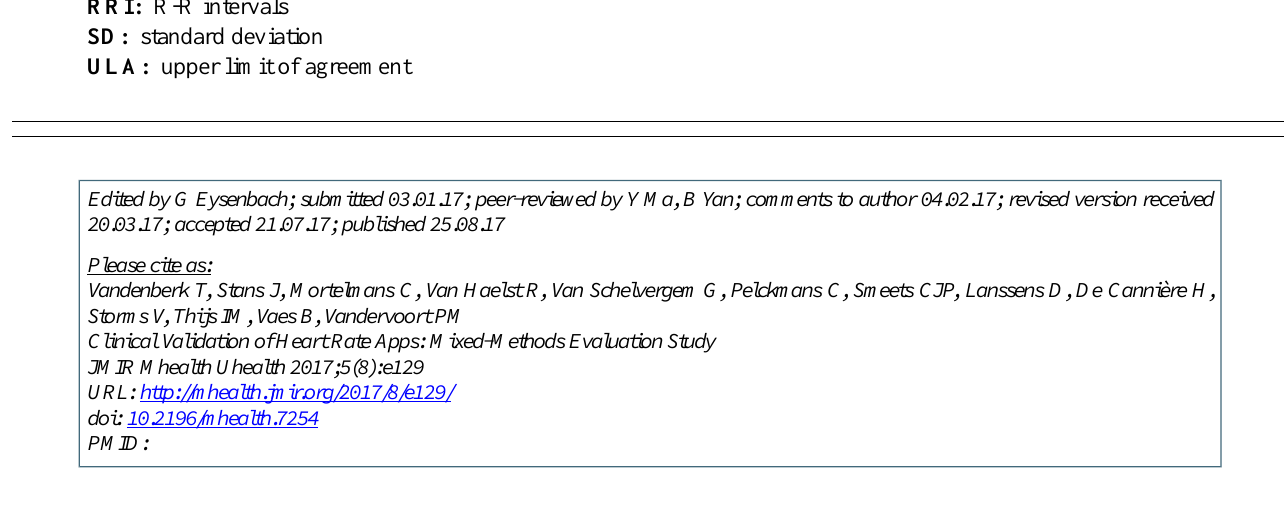
PPI: peak-to-peak interval PPG: photoplethysmography RGB: red, green, and blue RMSE: root mean square error RRI: R-R